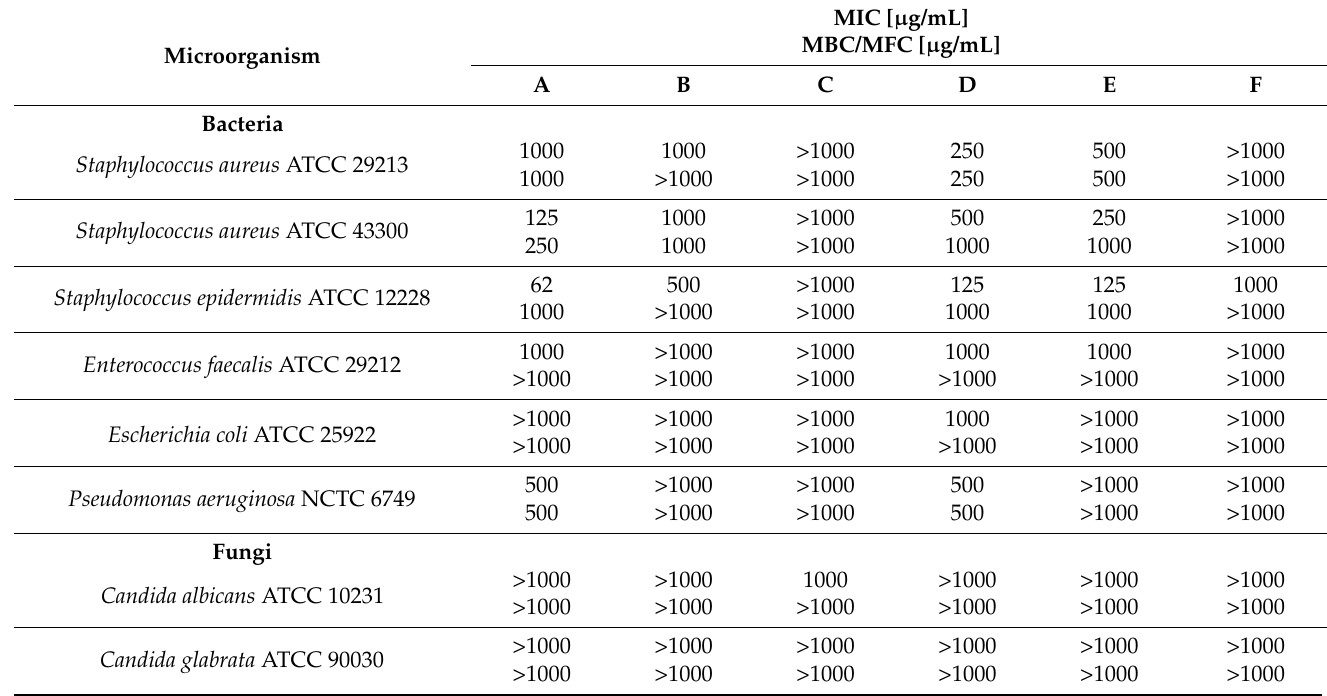
Table 1 demonstrates comparative effects of the six preparations (A–F) from sea buckthorn leaves and twigs concentration at –10 µ g/mL) on two selected parameters of oxidative stress: lipid peroxidation and protein carbonylation, in plasma treated with H 2 O 2 /Fe. Four tested preparations (C–F) had stronger antioxidant activity than two other used preparations (A and B). For example, preparations C–F inhibited lipid peroxidation and protein carbonylation (Table 1). Table 1. Antioxidant activity of phenolic preparations (A–F; 10 µ g/mL) from E. rhamnoides leaves (A–C) and twigs (D–F). Preparation Oxidative Stress Lipid peroxidation No effect inhibition inhibition inhibition inhibition inhibition Protein carbonylation No effect No effect inhibition inhibition inhibition inhibition 2.4. Antimicrobial Activity of Phenolic Preparations from Sea Buckthorn Twigs and Leaves Antimicrobial effect of fractionated sea buckthorn preparations was presented in Table 2 as minimum inhibitory and bactericidal/fungicidal concentrations (MIC and MBC/MFC) against a broad panel Gram-positive and Gram-negative reference bacterial strains, as well as against fungi from Candida sp. Table 2. Antimicrobial activity of phenolic preparations (A–F) from E. rhamnoides leaves (A–C) and twigs (D–F).